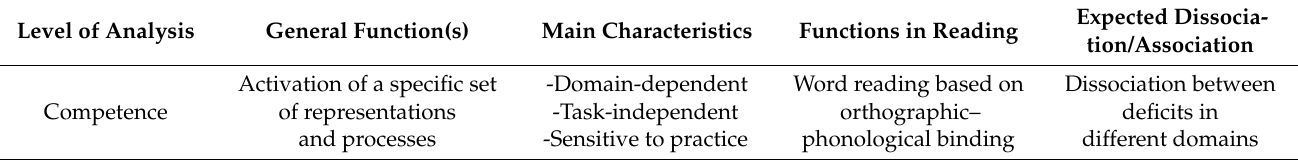
Table 1. Main functions and characteristics of competence, performance, and acquisition levels as related to individual differences in cognitive processing in general and more specifically for reading. In the last column, the expectation in terms of dissociation/association for deficits at different levels is spelled out, e.g., it is expected that competence deficits in different domains will dissociate from each other whereas deficits in automatization will be found in different domains (see text for a more thorough presentation). In the table, “domain” is a broad term that indicates areas of cognitive function (such as language or spatial orientation as well as reading and math). “Behavior” refers more restrictively to action, or function, that can be objectively observed or measured in response to controlled stimuli. The term “task” refers to the peculiar characteristics of the goal-oriented activity undertaken by the subject, such as reading aloud a sentence from left to right on a static display. The term “item” refers to the specific instance considered, such as a given word (e.g., “mother”) in the case of